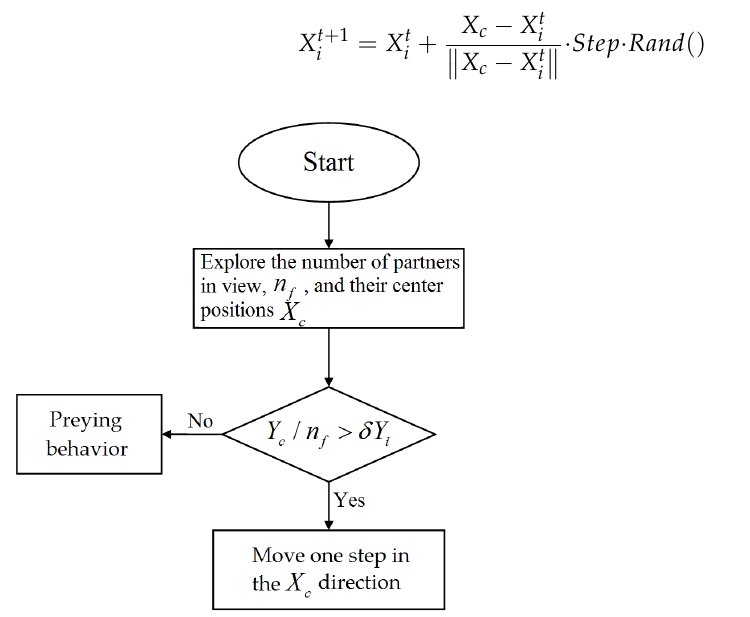
Figure 1. Flow chart of swarming behavior in AFSA. Figure 1. F low chart of swarming behavior in AFSA. Figure 1. F low chart of swarming behavior in AFSA.